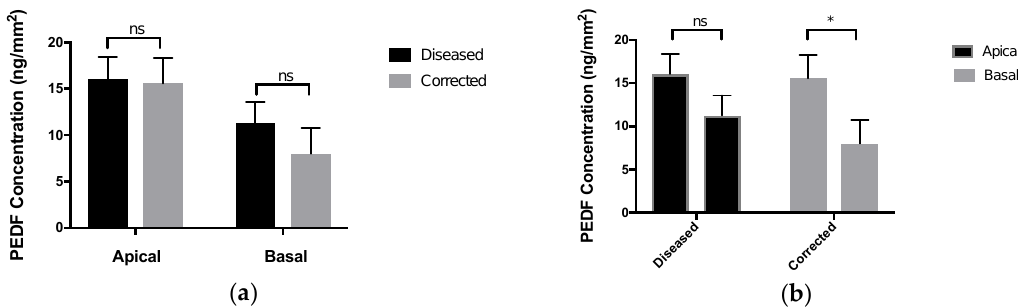
Figure 3. Localization of RPE-specific proteins at passage 3 on day 30. Immunocytochemistry revealed proper localization of RPE-specific proteins and PRPF8 (40× objective): ( a , b ) premelanosome 17; ( c , d ) bestrophin 1; ( e , f ) zonula occludens; ( g , h ) PRPF8. Scale bars are 50 µm.